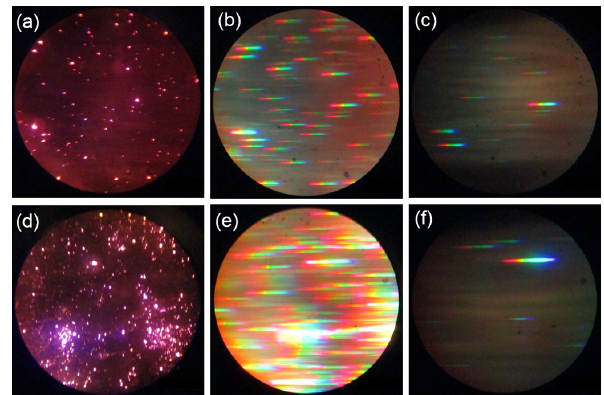
Figure 4. Images showing minority of fluorescent particles amidst large quantity of other particles. Top panels (a–c) : outdoor ambient particles collected via natural settling onto microscope slide. Bot- tom panels (d–f) : ground optical fused quartz particles. First column (a, d) shows conventional micrograph images ( θ = 0) illuminated with red laser light. Second column (b, e) shows white-light scat- tering spectra after illumination of same scene with polychromatic light from tungsten source. Third column (c, f) shows fluorescence spectra after illumination of same scene with 405nm diode laser and blocking filter in place. Images acquired magnified using 10 ×